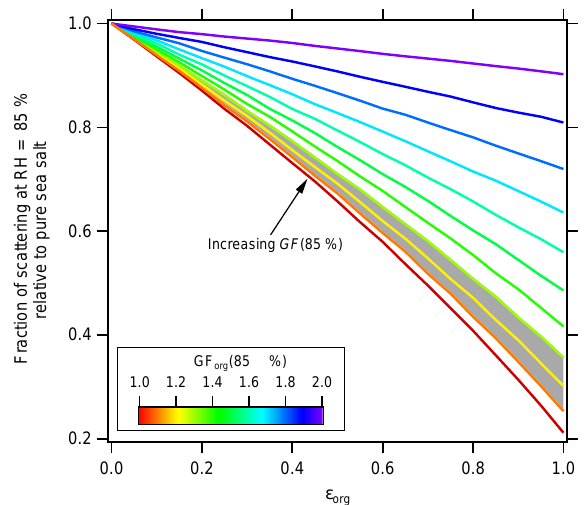
Figure 6. Calculated fraction of scattering relative to pure sea salt particles at 85% RH as a function of ε org , assuming the OM com- ponent of the SSA particles have the same constant hygroscopic- ity and a refractive index of 1.55 and the SSA particles follow the ZSR mixing rules. The different curves are colored according to the assumed GF org (85%) value, ranging from 1.0 to 2.0, given GF sea salt (85%) = 2.1. The gray band shows the range of GF org val- ues indicated by the current